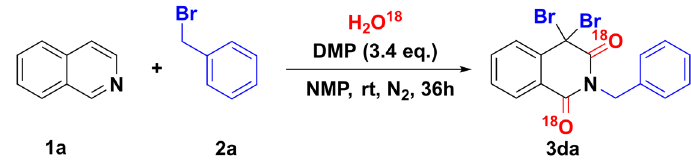
Figure 7. Mechanistic